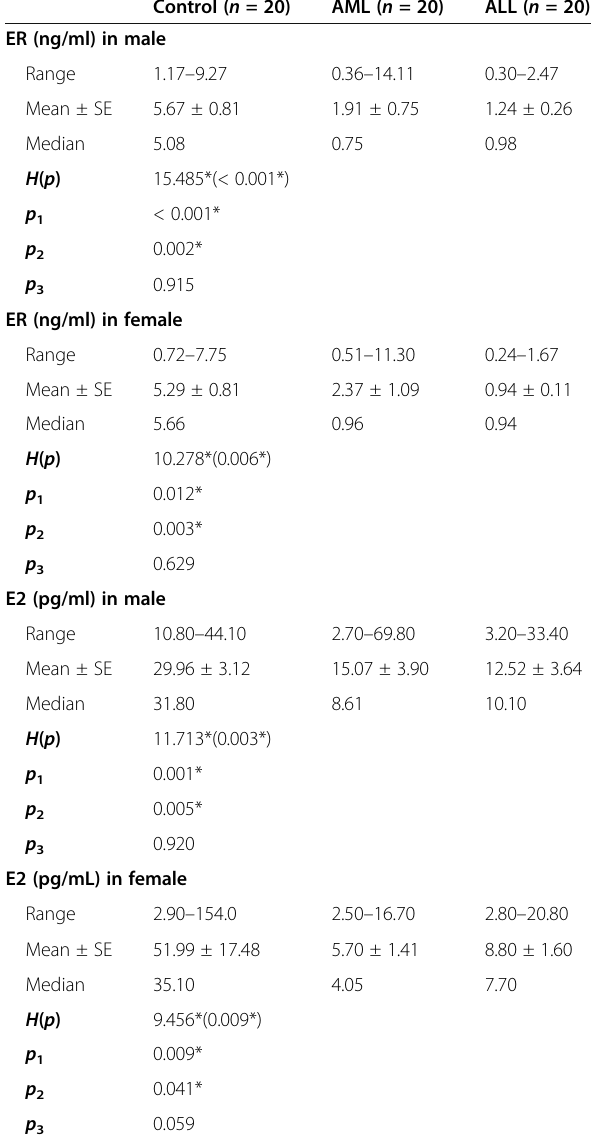
Table 1 Serum ER level (ng/ml) and E2 level (pg/ml) in AML and ALL male/female patients and control